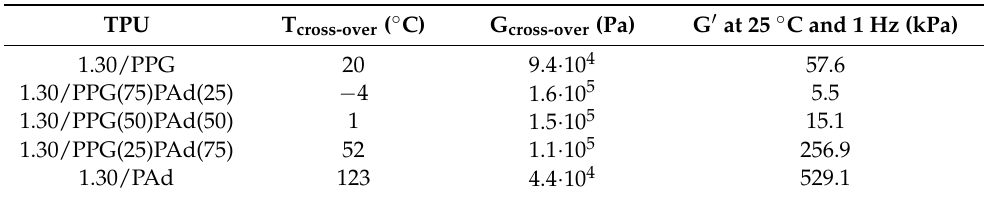
Figure 8. Variation of the storage modulus (G’) as a function of the temperature for the TPUs. Temperature sweep plate-plate rheology experiments. Table 6. Temperature (T cross-over ) and modulus (G cross-over ) at the cross-over of the storage and loss moduli of the TPUs. Temperature sweep plate-plate rheology experiments.